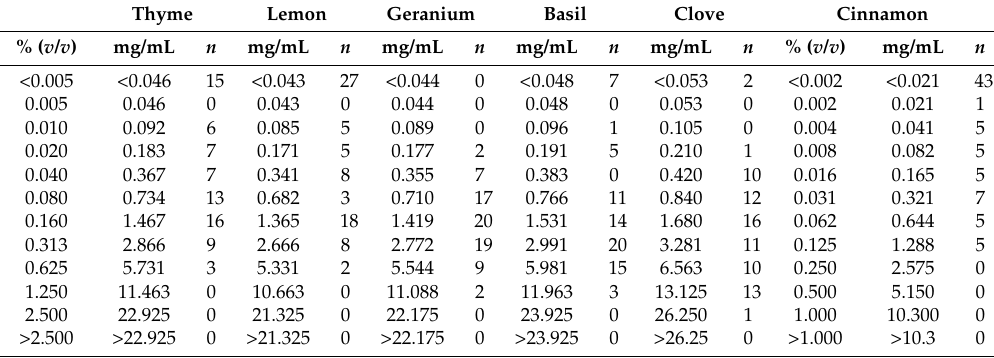
Table 3. Number of isolates with exact MIC value of the selected essential oil in the group of 76 C. glabrata clinical isolates.